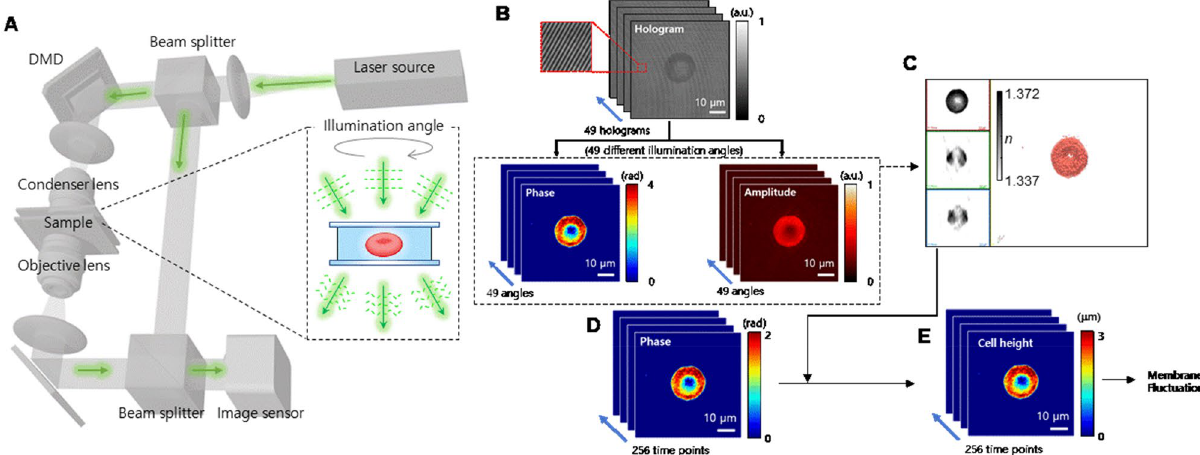
Figure 5. Workflow of the HT system for analysing holotomographic results. ( A ) depicts the used HT system. ( B – E ) shows analysis procedure. ( B ) From the multiple 2D hologram patterns of a sample obtained with various illumination angles, both the phase and amplitude images were retrieved. ( C ) From these phase and amplitude images, a 3D RI tomogram is reconstructed. ( D ) Also, the time-lapse phase images of the RBC were recorded with normal illumination. ( E ) Then, from the measure phase images, the time-lapse cell height images were calculated by considering the mean RI values obtained in ( C